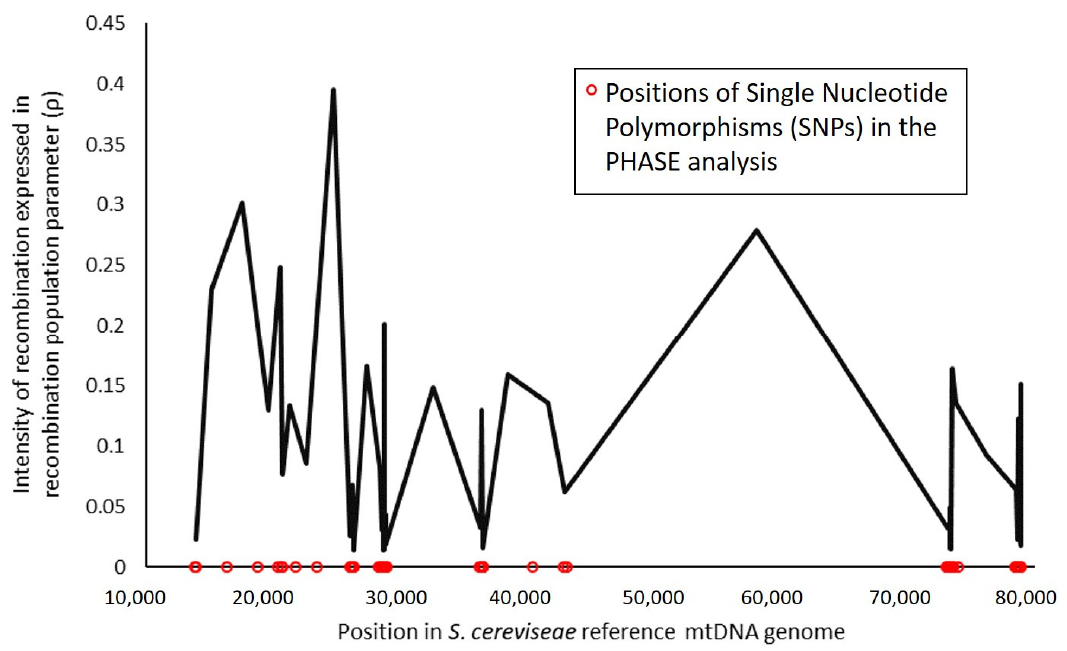
Figure 2. Intensity of recombination in the Saccharomyces cerevisiae mitochondrial genome in relation to an estimated background recombination rate, expressed in recombination population parameter.